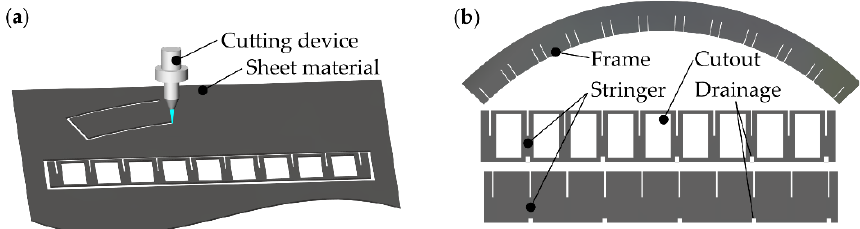
Figure 14. ( a ) Process of cutting the components of the resonator cavity out of sheet material, i.e., water jet or laser cutting, ( b ) curved frame with slits, the stringer with and without cut-outs for the flexible film.